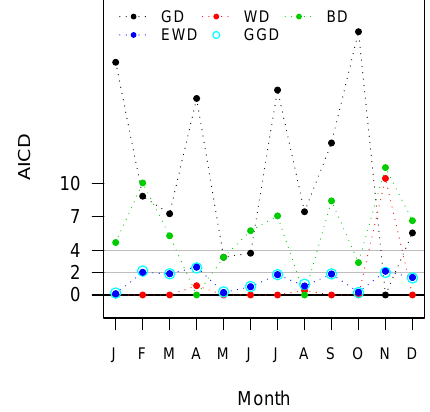
Fig. 2. Akaike differences (AICD) yielded by the gamma (GD), Weibull (WD), Burr Type III, (BD), exponentiated Weibull (EWD) and generalised gamma (GGD) distributions for England and Wales precipitation separately for each month.